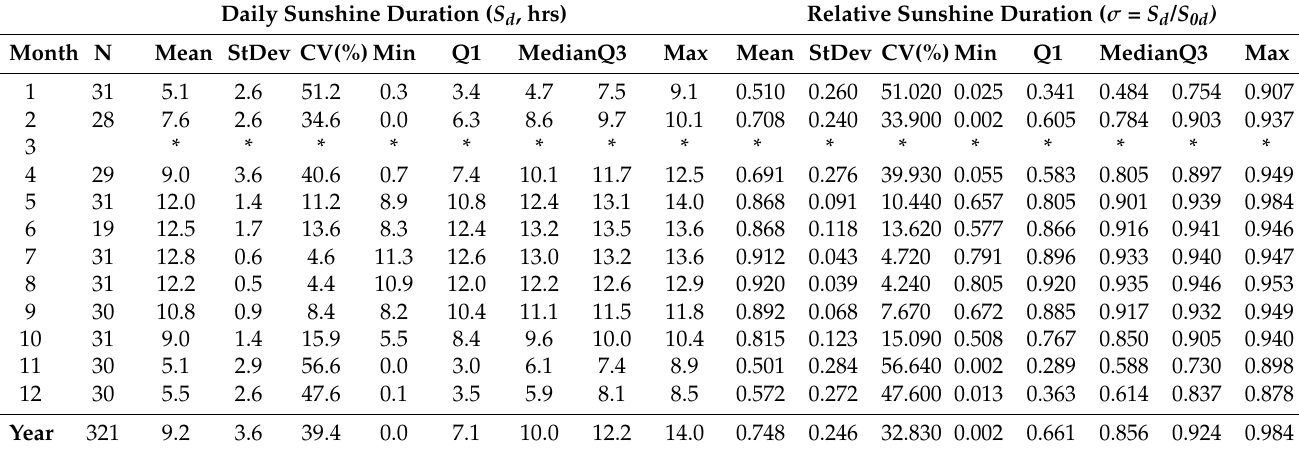
Table 10. Descriptive statistics of daily sunshine duration and its relative sunshine duration for each month of the year. Note: * means no records.